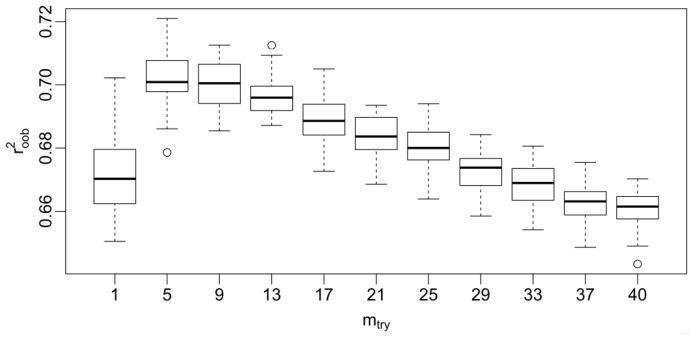
Boxplot of 50 replications of OOB estimation (r2oob) at various values of mtry. Horizontal lines inside the boxes are the median correlation.